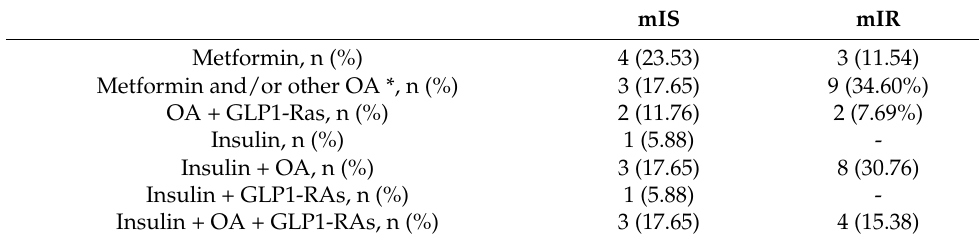
Table 2. Antidiabetic treatment of patients included in the